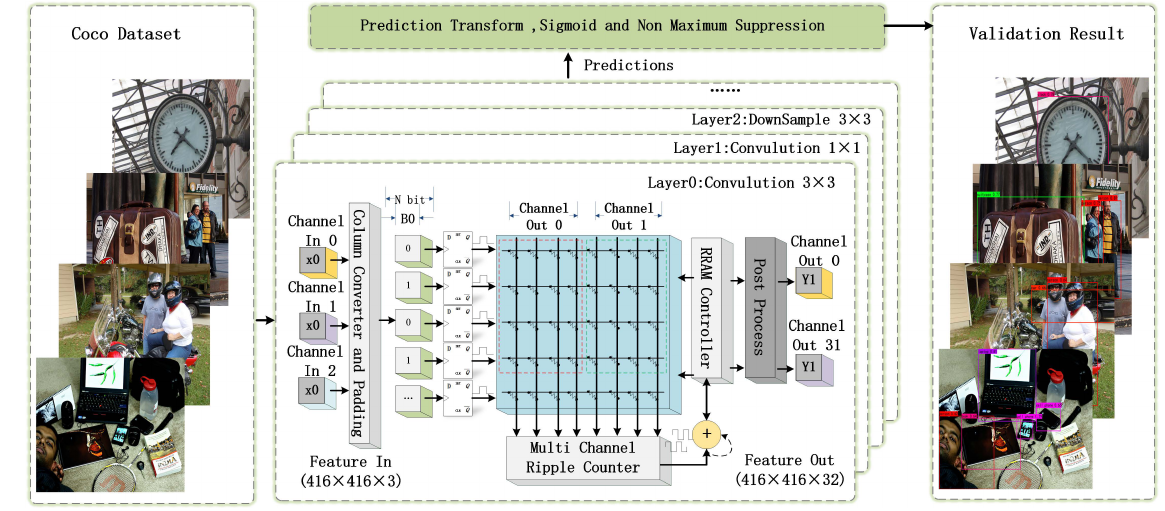
Figure 7. Illustration of image identification using the proposed RRAM PIM. Table 2. The architecture parameters of the overall simulation.